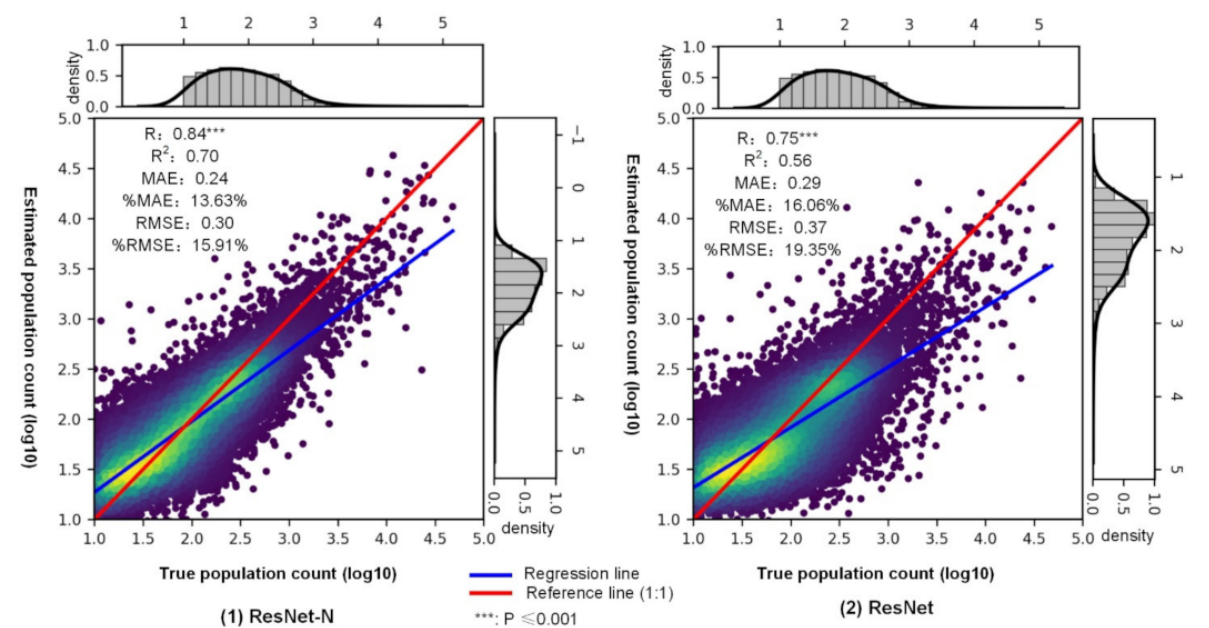
Figure 7. Scatterplots and probability density distributions of ground-truth population count and estimated population count from ResNet-N and